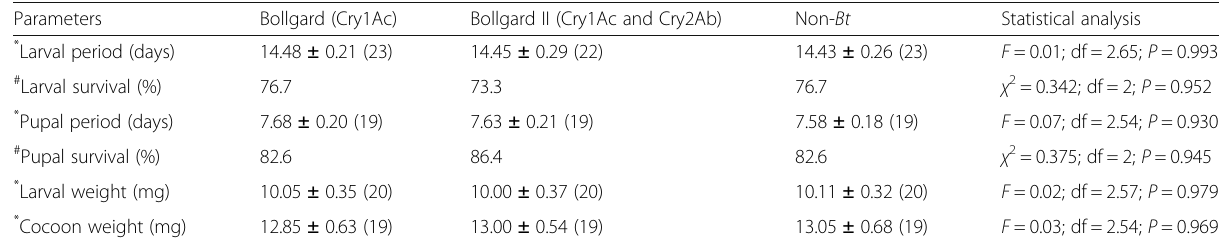
Table 3 Development time and survival of Chrysoperla zastrowi sillemi fed on Amrasca biguttula biguttula reared on Bt and non- Bt cotton